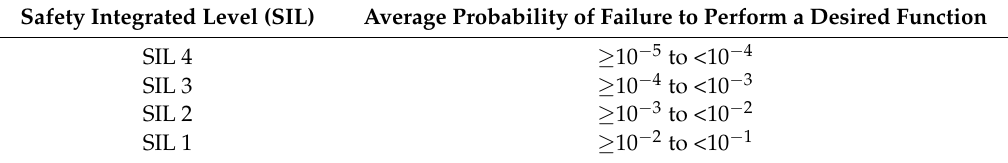
Table 4. Target failure measures for SILs of safety function (in low-demand